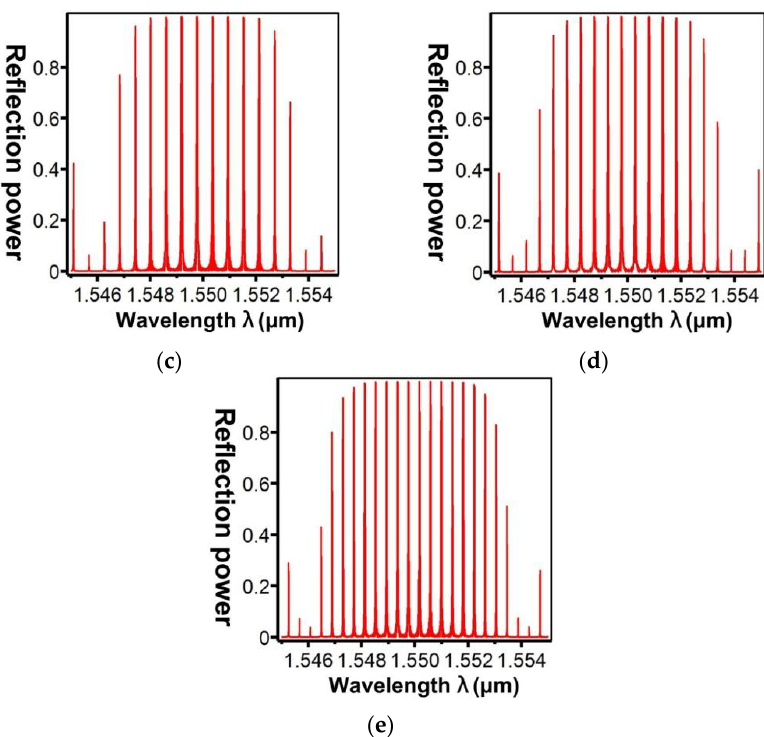
Figure 17. SFBG spectra at Λ SFBG = 0.5371029 μm: ( a ) duty cycle = 50%; ( b ) duty cycle = 33.33%; ( c ) duty cycle = 14.28%; ( d ) duty cycle = 12.5%; ( e ) duty cycle = 10%.